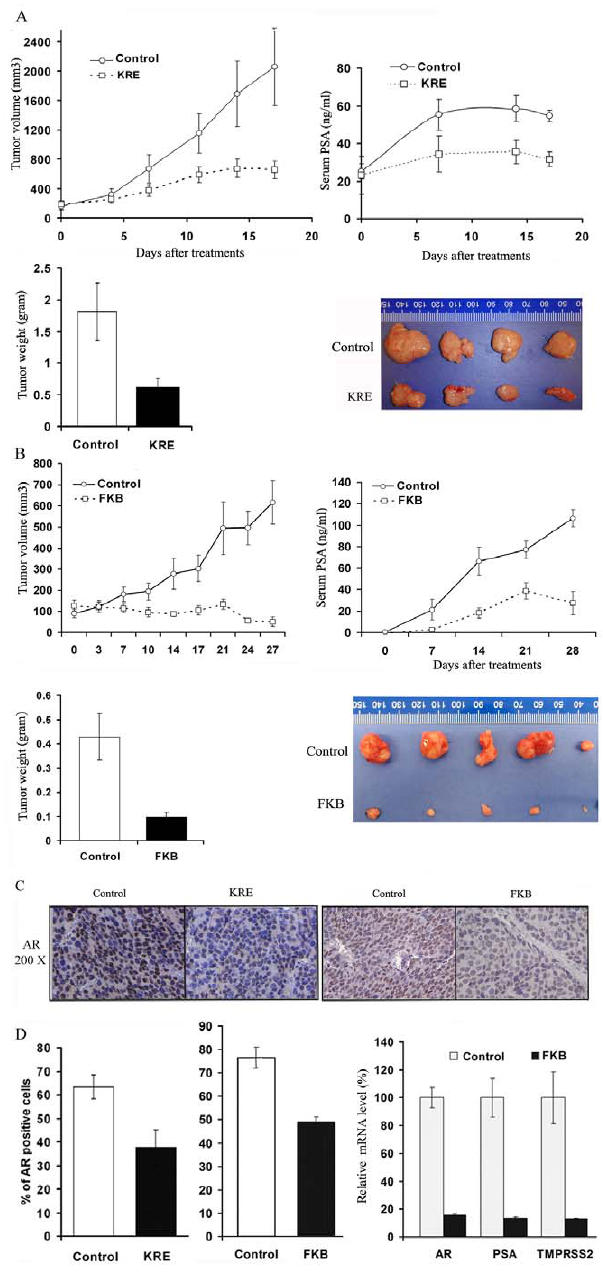
Figure 7. Kava root extract and FKB inhibit tumor growth, reduce serum PSA levels and decrease AR expression in tumor tissues in patient-derived PCa xenograft models. ( A ) and ( B ). The mice bearing patient-derived PCa tumors were randomly divided into treatment and control groups with similar pre-treatment serum PSA levels in each group. Tumor volumes and serum PSA were recorded, and presented as mean 6 SD. Wet weight of tumors is represented as mean of tumors from individual mouse in each group. Bars, means 6 SD. The tumor volumes (repeated-measures analysis of variance (ANOVA), p , 0.01) and tumor weights (Student t test, P , 0.01) of FKB and the KRE treated mice were significantly lower than those of vehicle control treated mice. ( C ). Immunohistology staining of AR expression in tumor tissues. Control immunostaining was performed with IgG isotype alone; Slides were counterstained with hematoxylin and photographed using a light microscope. Original magnification: 6 200. ( D ). AR positive cells were counted in 12 fields in each group. The percentage of AR positive cells was calculated and presented as mean 6 SD (the left